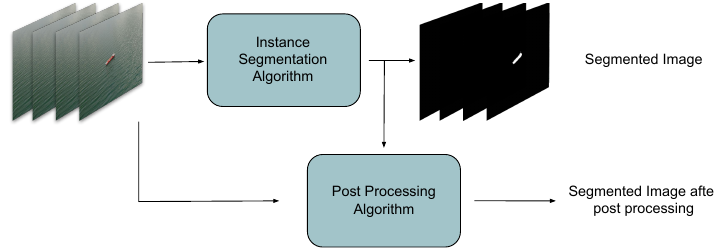
Figure 3. Overall system